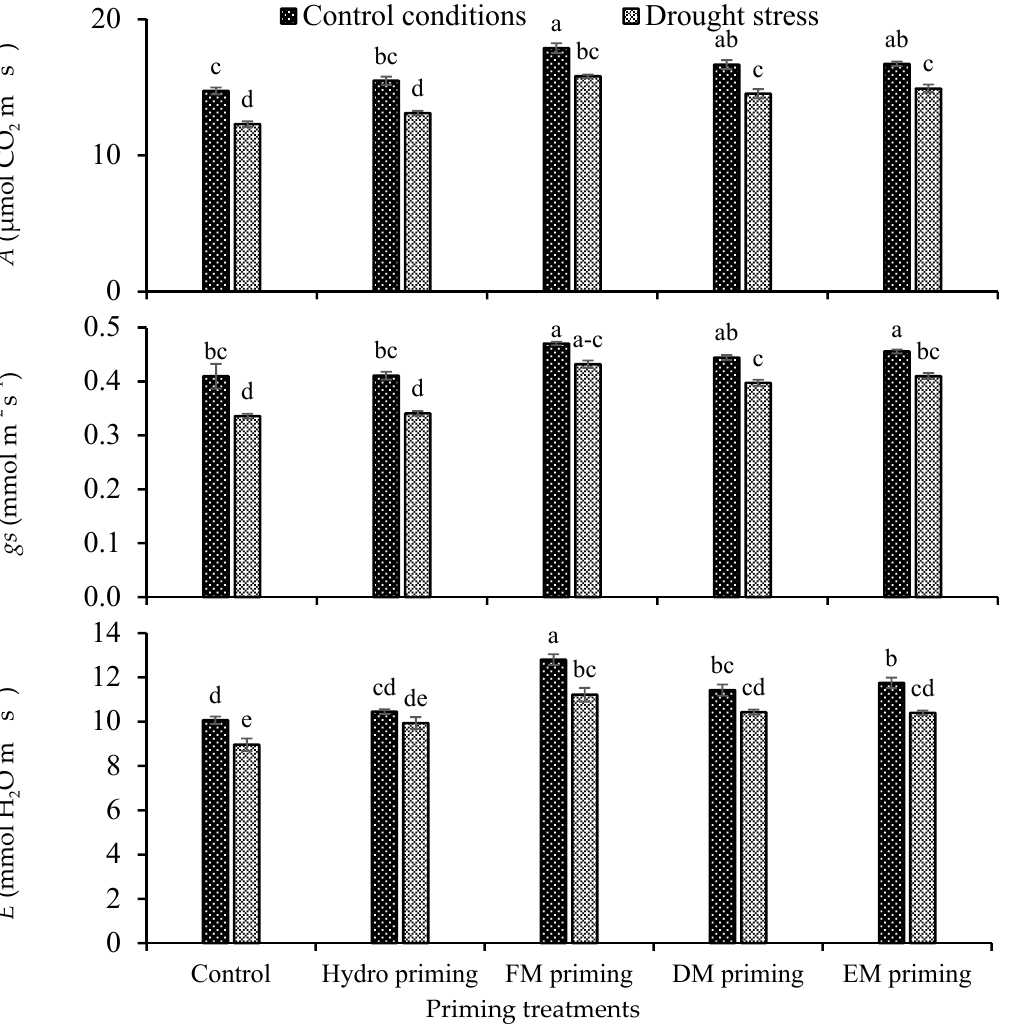
Figure 2. Impact of moringa leaf extracts as priming agents on gas exchange attributes of rice seedlings cultivated under control and water deficit regimes. Bars sharing the same letter did not differ significantly at p = 0.05.